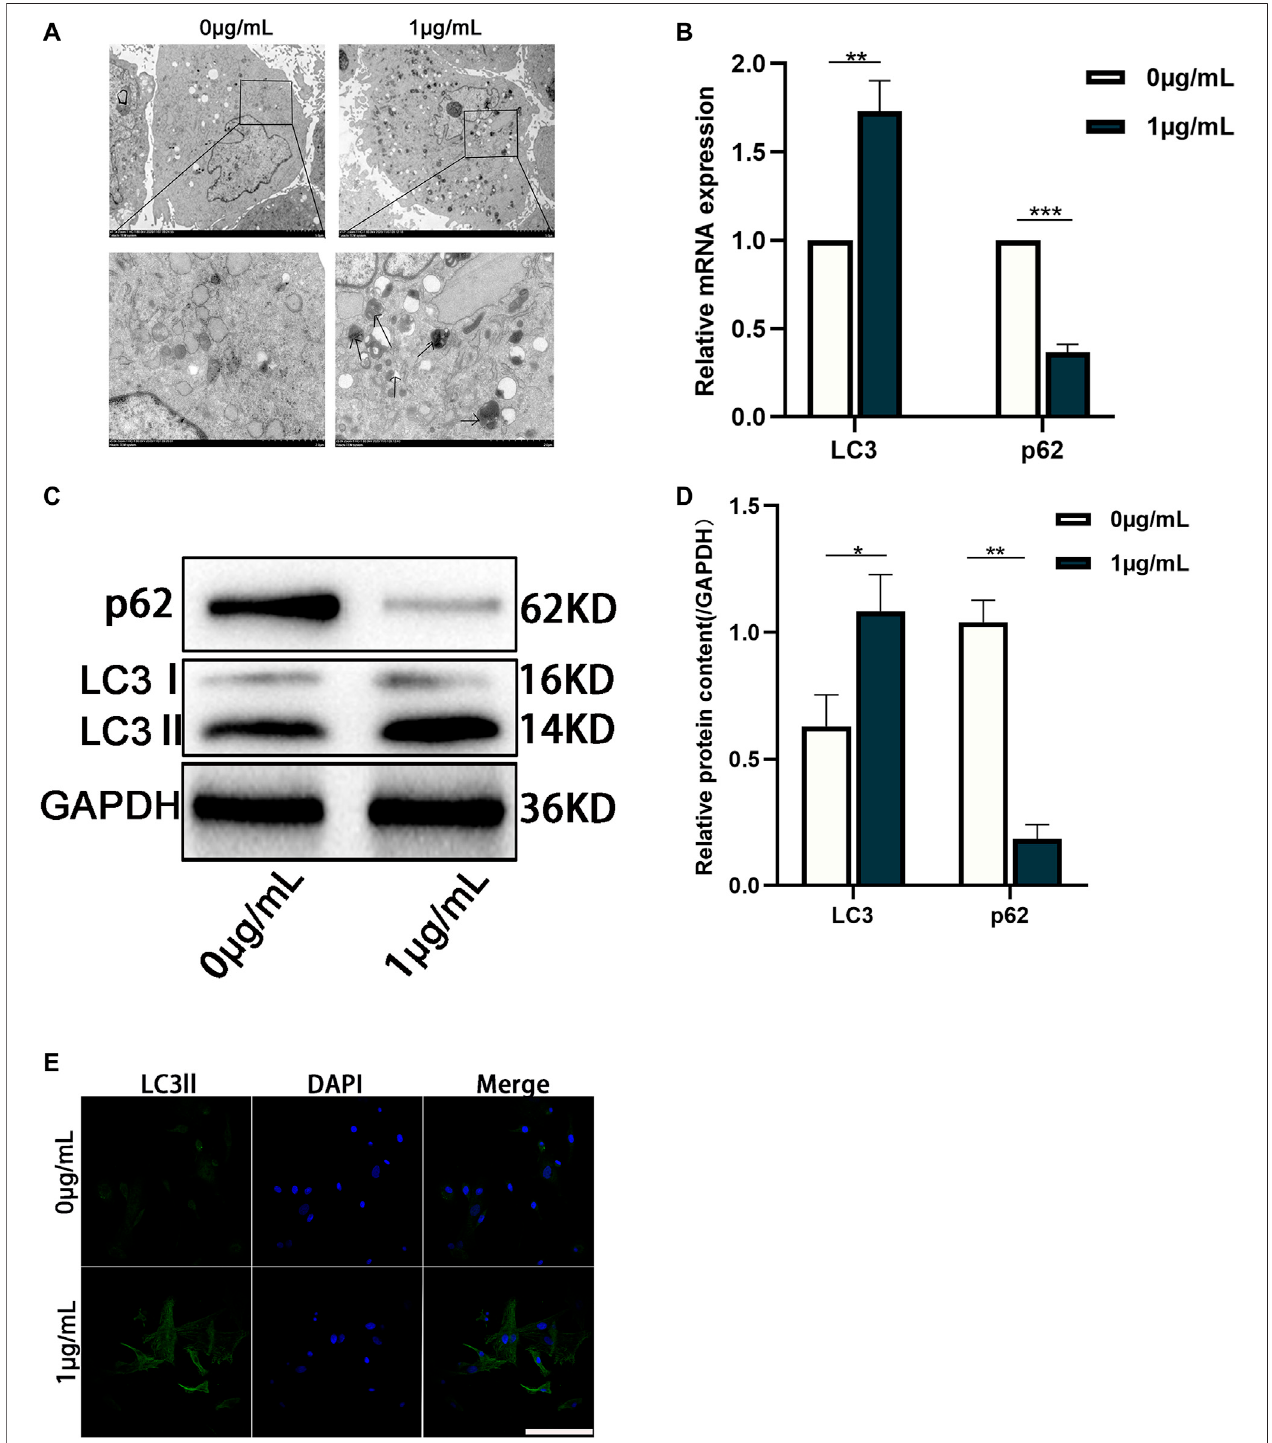
FIGURE 4 | Autophagy is activated in the osteogenic differentiation of BMSCs treated with CHNQD-00603. (A) TEM was used to observe the number of autophagosomes on day 7. (B) qRT-PCR was performed to detect the expression of autophagy-related gene LC3 and p62. (C,D) Western blot and quantitation were performed to analyze the expression of proteins LC3 and p62. (E) Immuno fl uorescence staining was used to observe the distribution of LC3 (scale bar (cid:1) 50 µm). Quantitative data are presented as the mean ± SD (n (cid:1) 3) (** p < 0.01, *** p < 0.0001).